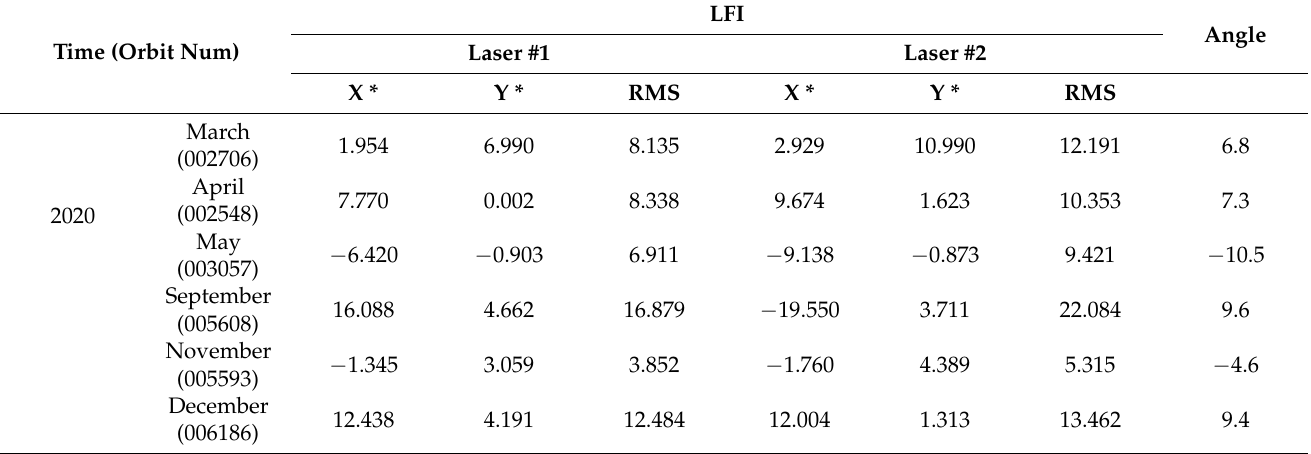
Table 6. Sampling inspection of plane accuracy evaluation of the laser footprint image (LFI) under the condition of the satellite in rolling (unit: